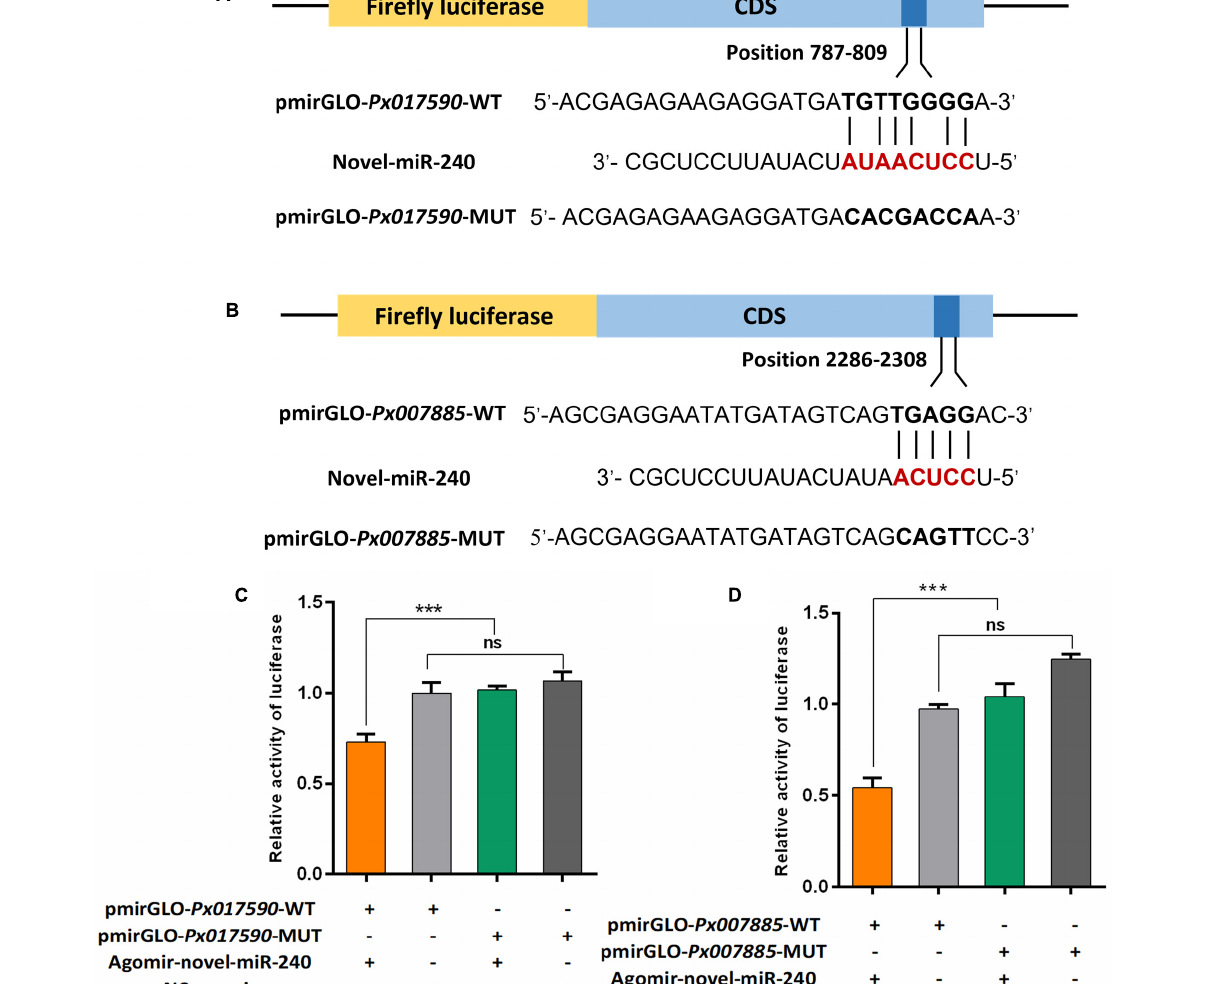
proteins in whitefly Bemisia tabaci (Gennadius) biotype Q and modulated insect reproduction and growth (Li et al.,